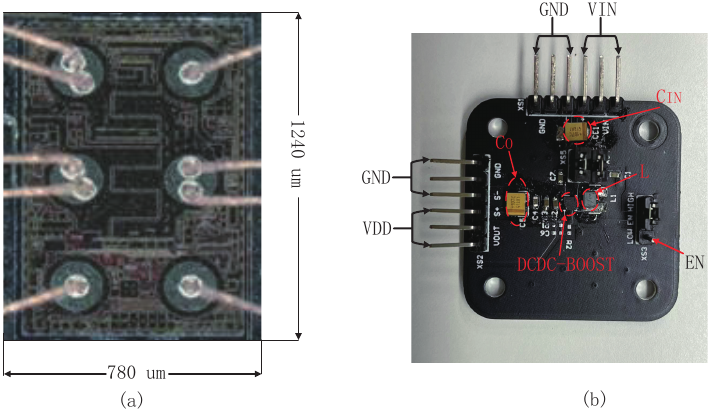
Figure 10. Microphotograph and Measurement board of the proposed DCDC Boost converter. ( a ) Microphotograph of the proposed DCDC Boost converter. ( b ) Measurement board of the proposed DCDC Boost converter.